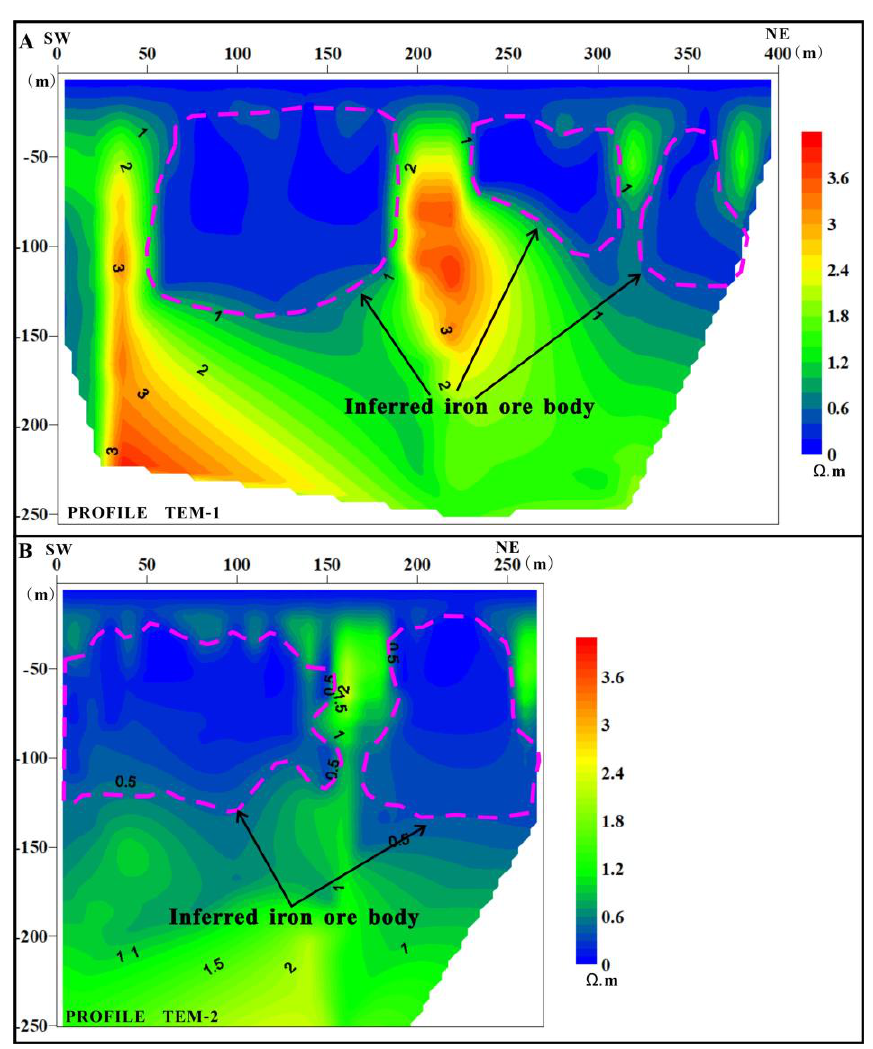
Figure 7. Transient electromagnetic method (TEM) data inversion results from the TerraTEM survey. ( A ) The resistivity section of the TEM profile TEM‐1; ( B ) The resistivity section of the TEM profile TEM‐2.